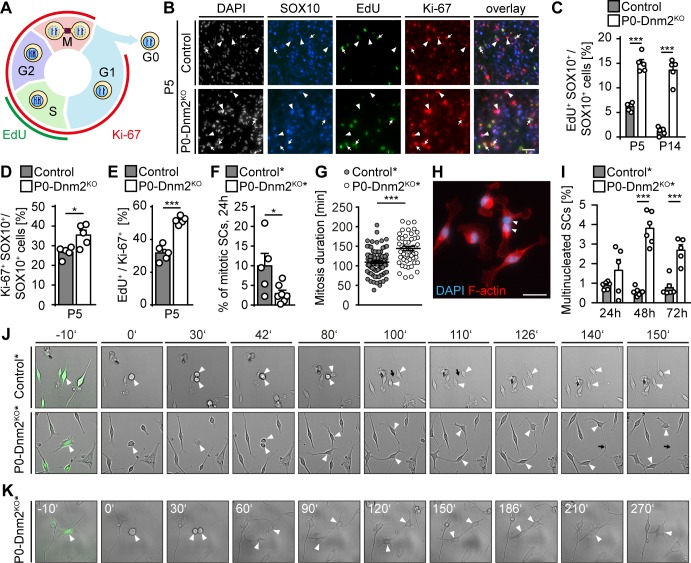
Schwann cells lacking dynamin 2 show impaired cell cycle progression, reduced mitosis rate, and cytokinesis defects.(A) Schematic representation of the cell cycle phases marked by Ki-67 and EdU. (B) EdU-labeling, combined with immunostainings for Ki-67 and SOX10 on control and P0-Dnm2KO SN cross-sections at P5. Arrows: EdU+ Ki-67+ SOX10+ SCs, arrowheads: Ki-67+ SOX10+ SCs. Scale bar = 25 μm for entire panel. (C) Quantification of (B). Percentage of EdU+ SCs/SN cross-sections. N = 5 mice/time point and genotype, Two-Way ANOVA with Sidak’s multiple comparisons test. (D) Quantification of (B). Percentage of Ki-67+ SCs/SN cross-sections at P5. N = 5 mice/genotype, two-tailed unpaired Student´s t-test. (E) Quantification of (B). Percentage of EdU+ among Ki-67+ SCs/SN cross-section at P5. N = 5 mice/genotype, two-tailed unpaired Student´s t-test. (F) Quantification of mitotic events in cultured mouse SCs isolated from MpzCre:Rosa26-stoploxP/loxP-YFP (control*) and MpzCre:Dnm2loxP/loxP:Rosa26-stoploxP/loxP-YFP (P0-Dnm2KO*) SNs at P1, monitored by time-lapse microscopy for 24 hr. Each data point represents one individual animal (at least 42 cells/animal analyzed). N = 5 controls and seven mutant mice, two-tailed unpaired Student´s t-test. (G) Quantification of mitosis duration (minutes) of SCs of control* and P0-Dnm2KO* mice, monitored by time-lapse microscopy for 24 hr. Each data point represents one cell derived from a total of 5 control and seven mutant mice. Cells derived from each animal were isolated and analyzed separately, but pooled in one graph; two-tailed unpaired Student´s t-test. (H) Exemplary picture of a multinucleated Dnm2KO SCs after 48 hr in culture. Scale bar = 25 μm. (I) Quantification of multinucleated cells in control and Dnm2KO SCs after 24 hr, 48 hr and 76 hr in culture. N = 6 mice/genotype for 48 hr; N = 6 control* and n = 5 P0-Dnm2KO* mice for 24 hr and 72 hr, two-Way ANOVA with Sidak’s multiple comparisons test. (J) Exemplary time-lapse images of the mitosis of control and Dnm2KO SCs (YFP+ cells). Arrowheads: cell body of dividing SCs, black arrows: cytokinesis site. (K) Representative time-lapse images of Dnm2KO SC (YFP+) failing cytokinesis. The SC is undergoing mitosis, but fails to divide (arrowheads point to the cell body). Results in graphs represent means ±s.e.m.; *p<0.05, ***p<0.001.